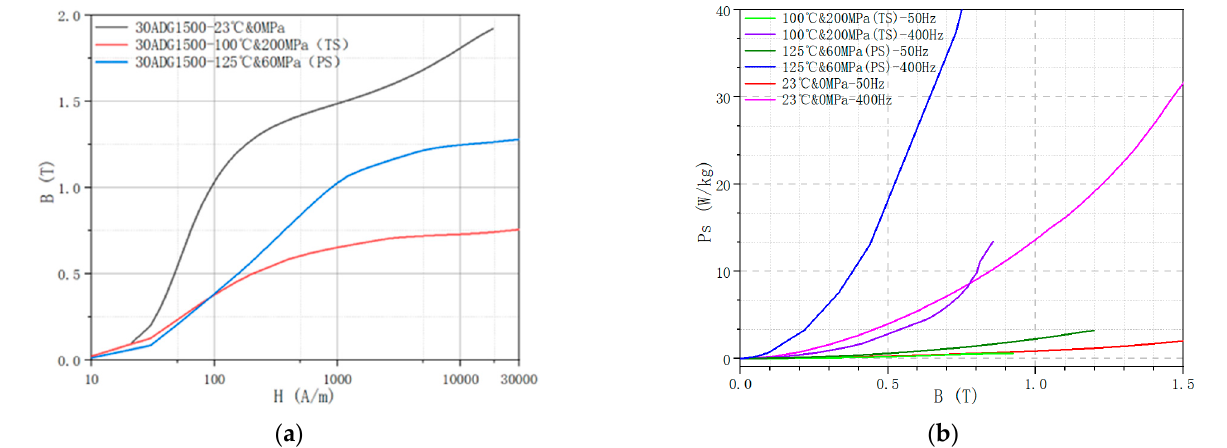
Figure 6. The magnetic characteristic of NGO silicon steel. ( a ) B-H curves; ( b ) B-P curves.